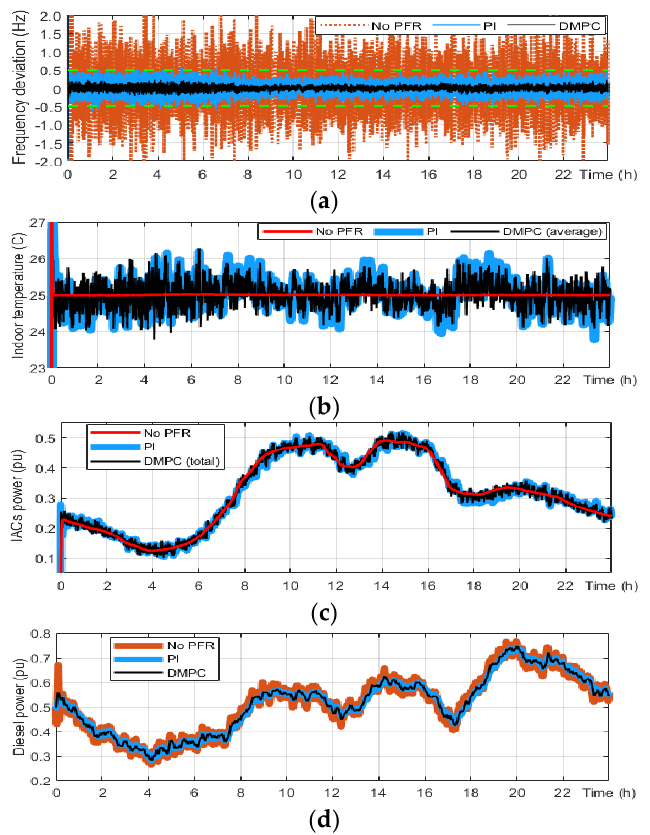
Figure 12. Simulation results of case 1 ( a ) frequency deviation (green dash lines are the fre- quency minimum and maximum limits), ( b ) indoor temperature, ( c ) IACs power consumption, and ( d ) diesel power.